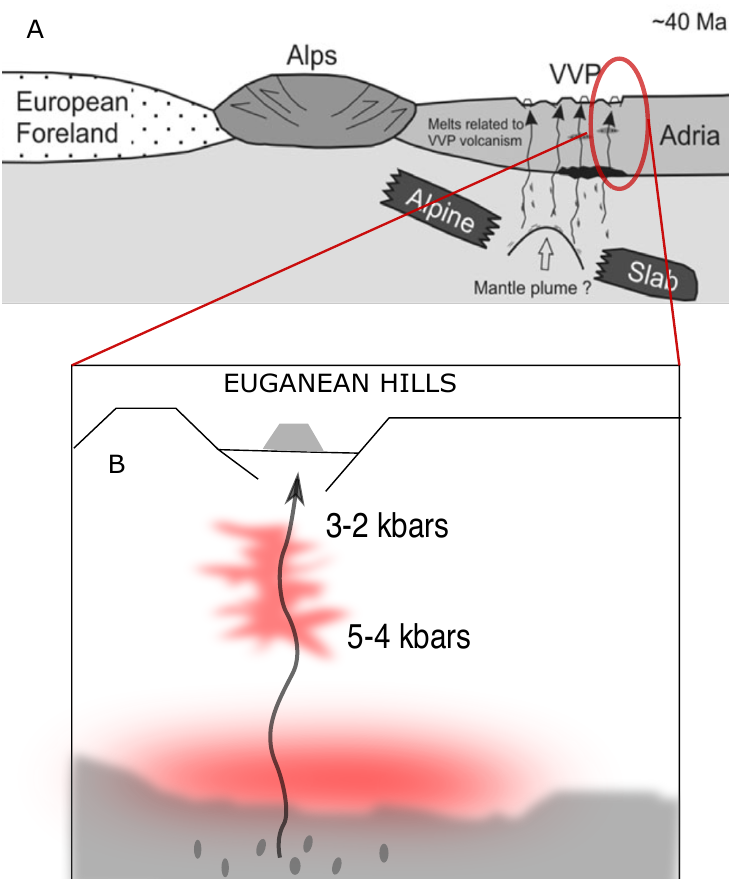
Figure 9. Schematic model of the Euganean Hills volcanic system. ( A ) Model of the VVP in the tectonic framework of the Alpine Orogeny modified from [30]. ( B ) Model for the Euganean Hills plumbing system, at the crust-mantle boundary a subduction-related basaltic melt formed mafic to ultramafic cumulates during Alpine subduction, the mantle-derived magma ascending ponded at middle-shallow crustal levels where